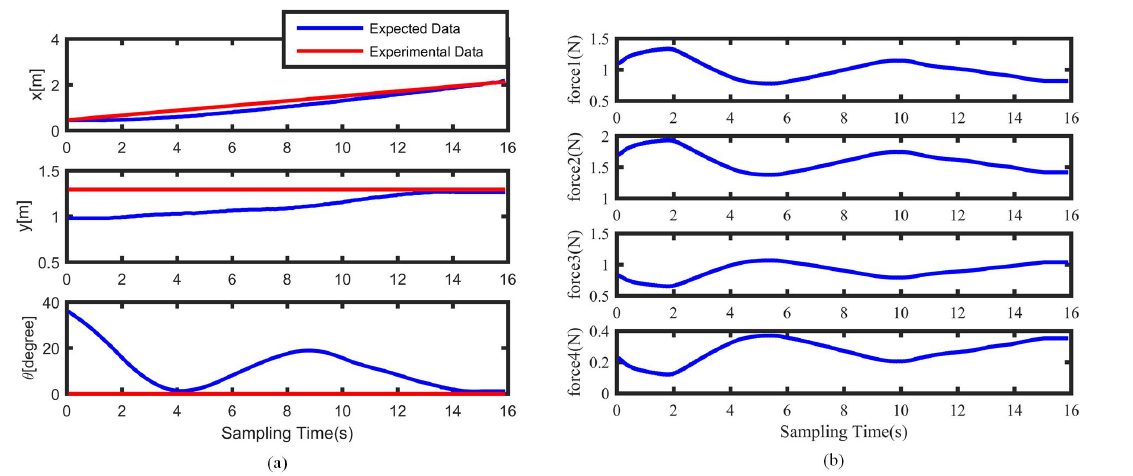
Figure 21. The tracking results of the robot in line tracking. ( a ) States of the robot at different times. ( b ) Thrusts varying of the four